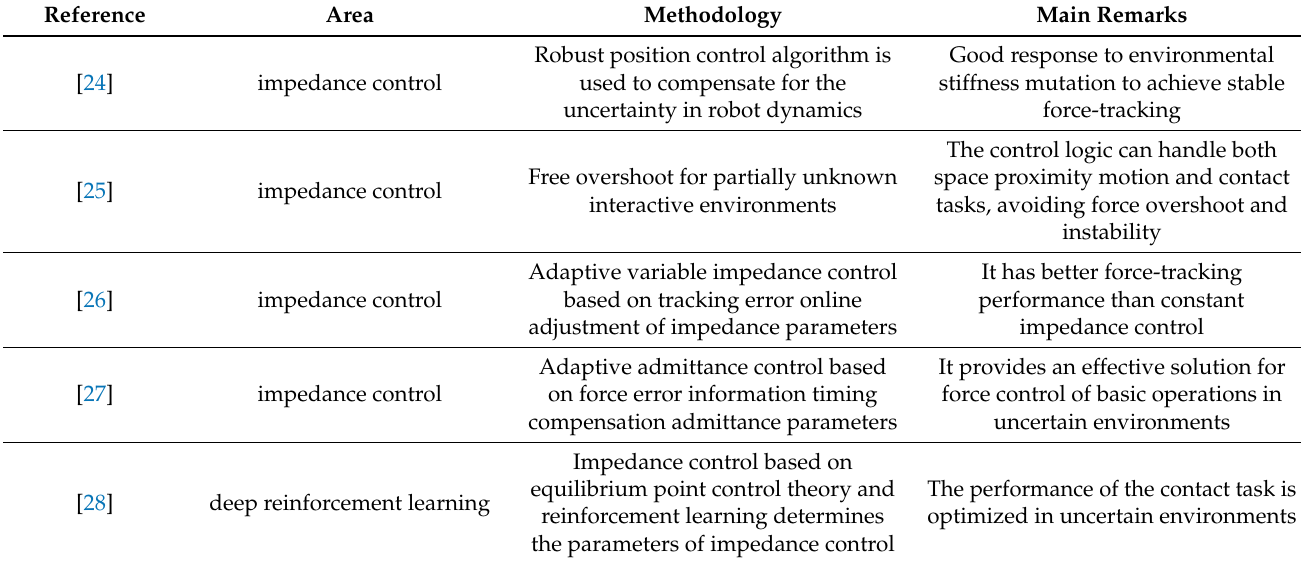
Table 1. Summary and comparison of impedance control methods and deep reinforcement learn- ing